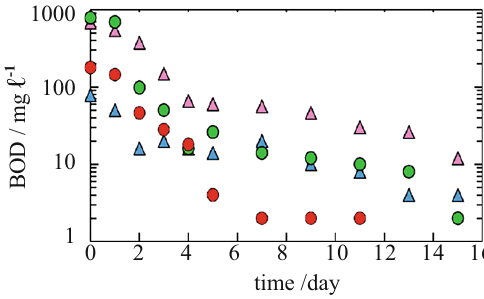
Fig. 4 Change of BOD in the artificial waste water (15 L) containing 10 mL of milk, 15 mL of AS, and 750 g of PC ( red circles ) or without the PC ( blue triangles ), and that in the water containing 100 mL of milk, 15 mL of AS, and 750 g of PC ( green circles ) or ‘‘without the PC’’ ( pink triangles